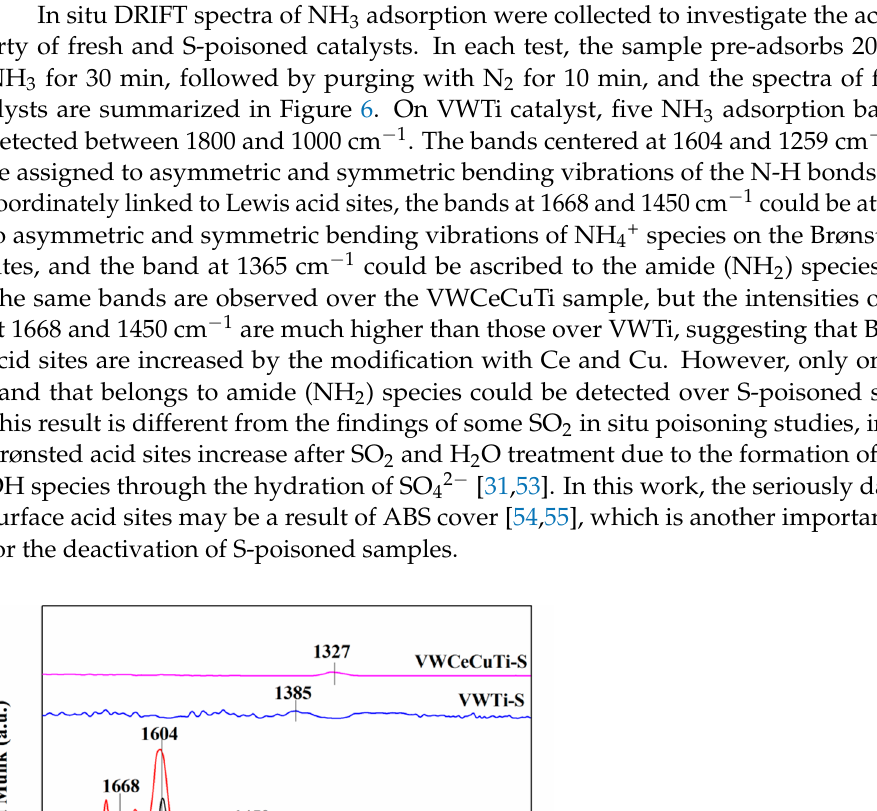
Figure 7. In situ DRIFT spectra of NO adsorption over fresh and S-poisoned samples at 250 °C. 2.6. Reaction between Ammonia and Adsorbed Nitrogen Oxides Species As discussed above, NO adsorption over S-poisoned catalysts is improved, so further experiments were conducted to investigate if these adsorbed NO x species could partici- pate in the NH 3 -SCR reaction. Figure 8 presents the DRIFT spectra of VWTi-S and VWCeCuTi-S in a flow of 2000 ppm NH 3 after catalysts pre-adsorbed NO + O 2 for 30 min and purged with N 2 for 10 min. As shown in Figure 8a, after introducing NH 3 , the inten- sities of NO adsorption peaks over VWTi-S decrease gradually, and disappear completely within 5 min. Subsequently, a new band (1327 cm − 1 ) ascribed to the NH 2 species appears. It indicates that all the adsorbed NO x species could take part in the SCR reaction. Similarly,